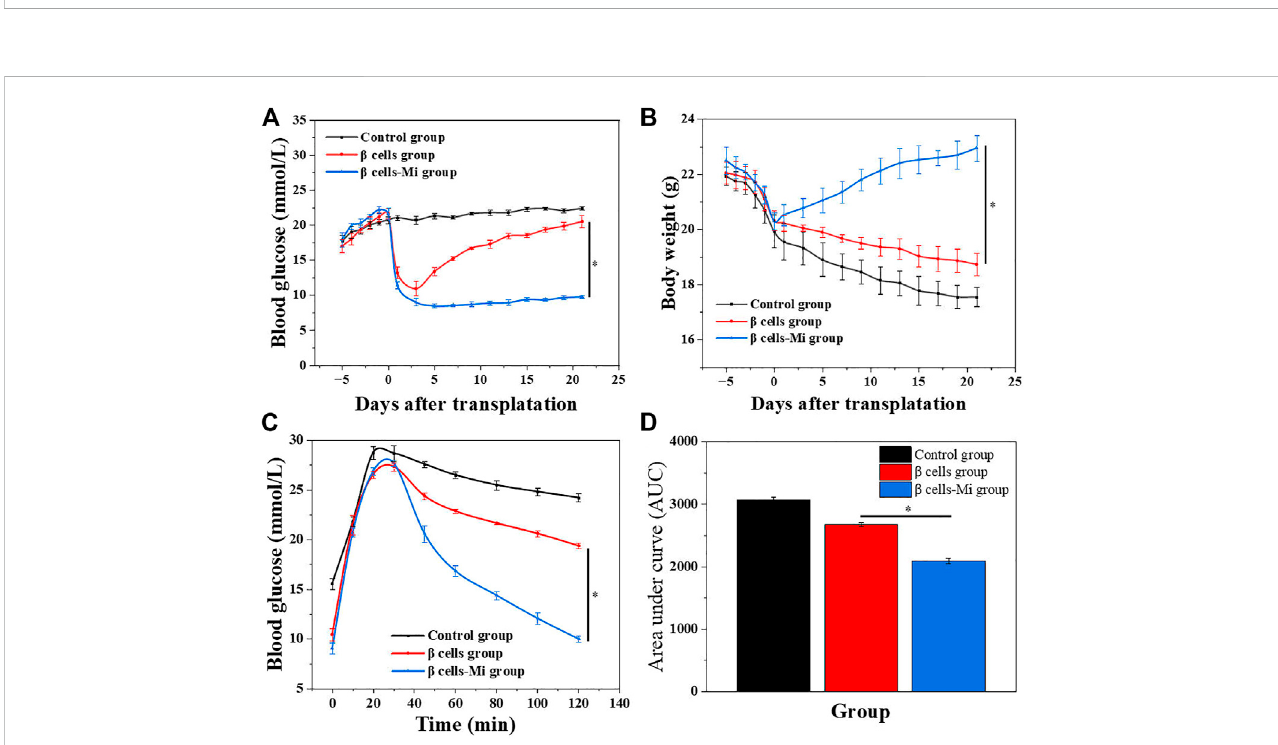
FIGURE 5 In vivo anti-diabetic ef fi ciency of the β -cell-encapsulated microcapsules. (A,B) Blood glucose levels and body weights after transplantation. (C) Glucose tolerance tests in diabetic mice in different groups 2 h post-administration. (D) Responsiveness was calculated based on the area under the curve (AUC) at 120